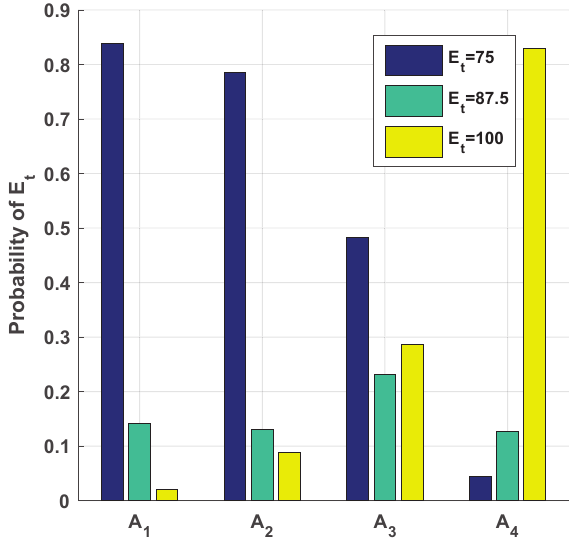
Figure 6. The probability of E t in different annular areas (AA), when M i = 130.